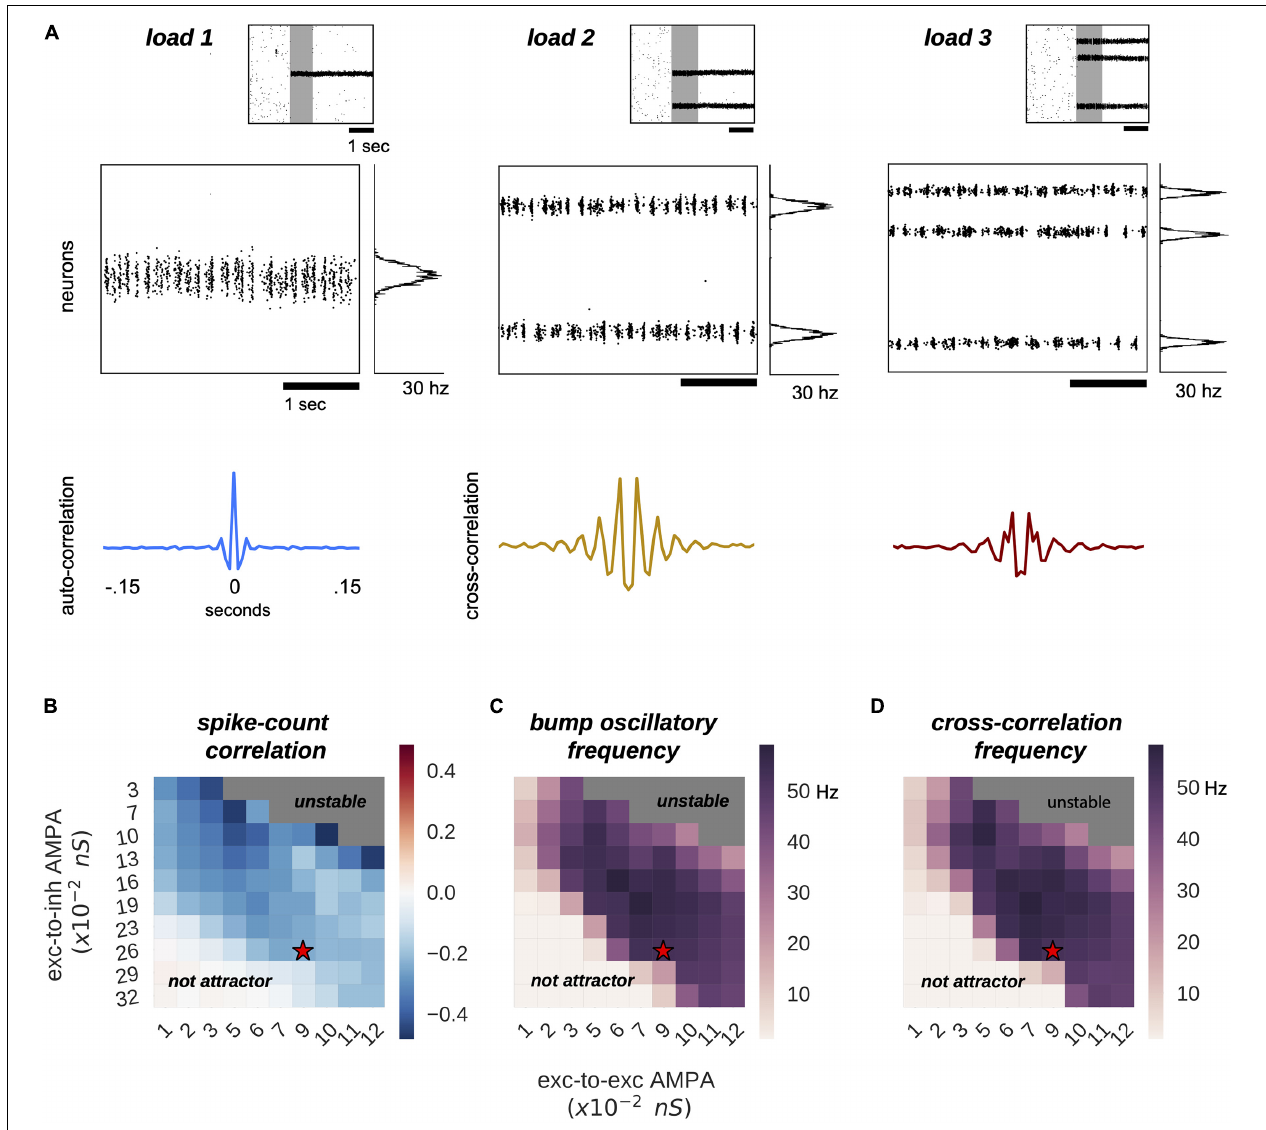
FIGURE 1 | Multiple bumps are spontaneously anti-correlated. (A) Raster plots of three sample simulations of load 1–3 ( top ) and delay-period zooms ( middle ) show clear bump oscillatory activity, confirmed by correlation functions ( bottom ). Notably, irregular activity coexists with oscillatory dynamics. (B–D) Anti-correlated oscillatory dynamics as excitation is manipulated in the network (AMPAR conductance for excitatory to inhibitory connections, Y-axis, and for excitatory to excitatory connections, X-axis) in simulations with load 2 for the capacity-2 network used in Figures 3 , 4 (to facilitate comparisons). (B) Anti-phase dynamics as measured by zero-lag cross-correlation between bumps. (C) Dominant frequency of the auto-correlation function computed independently for each bump (computed with Fourier analysis). (D) Dominant frequency of the cross-correlation between the two bumps. Red stars mark the parameter values of model simulations used throughout the study. Plots in panels (B–D) summarize the dynamics of ∼ 10,000 simulations (total) of 100 different